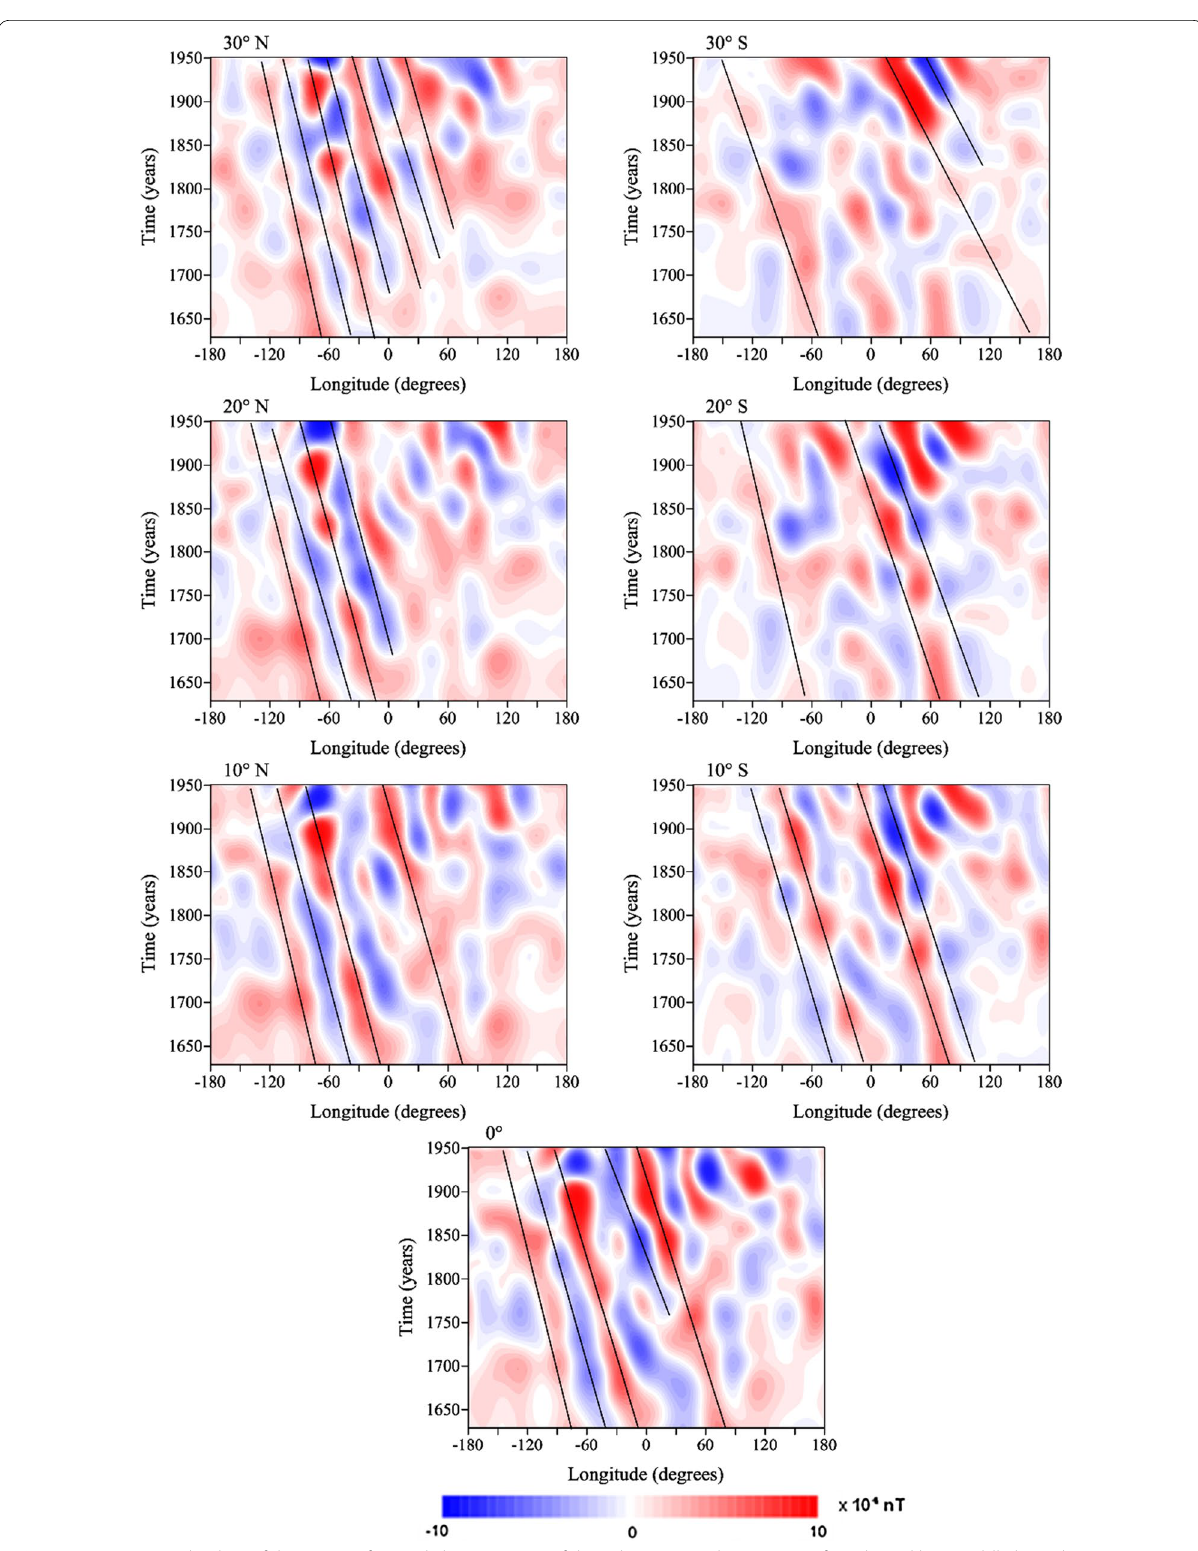
Fig. 3 Time–Longitude plots of the core surface radial component of the sub-centennial constituent for selected low-middle latitudes. Movement direction is highlighted by straight line